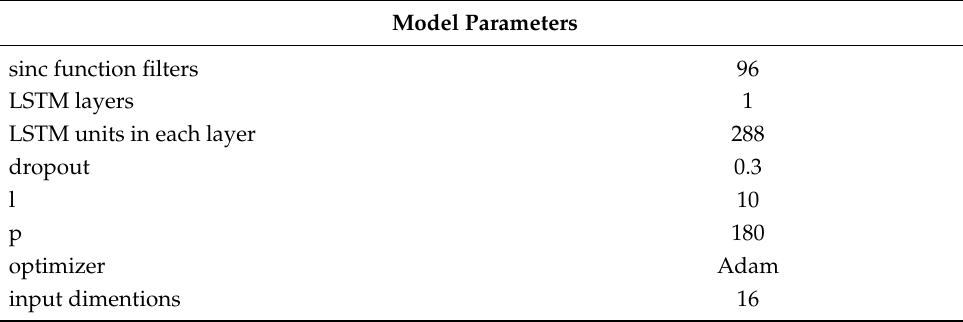
Table 1. Model parameters configure of Sinc-LSTM